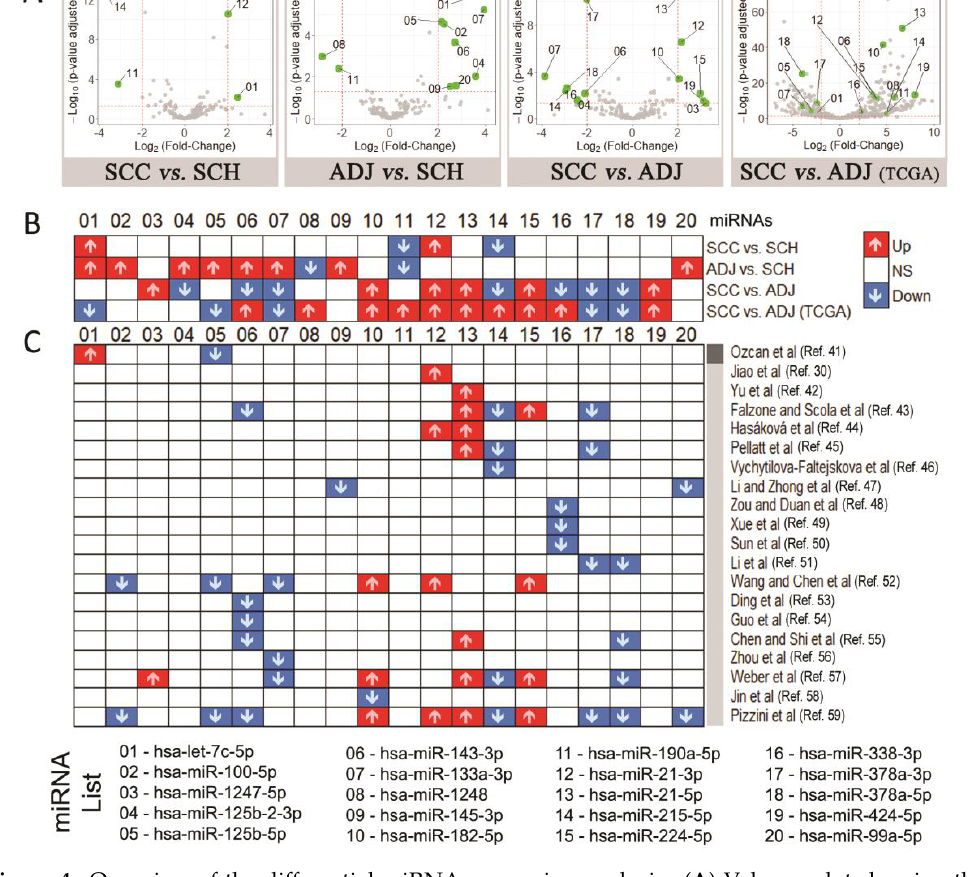
Figure 4. Overview of the di ff erential miRNA expression analysis. ( A ) Volcano plot showing the di ff erential expression analysis, ( B ) an overview of 20 di ff erential expressed miRNAs in this study, and ( C ) a comparison of these 20 miRNAs with results of previous studies with CRC patients. These studies were annotated as Dark-grey and Light-grey according to tissue considered as reference. Dark-grey = this study used a biopsy of a healthy subject as a reference against Colorectal Cancer (CRC). Light-grey = these studies used adjacent-tumor tissue as the reference against CRC. Note: Sigmoid Colon Cancer (SCC); Sigmoid Colon Healthy (SCH); Adjacent to Sigmoid Colon Cancer (ADJ). Up = Upregulated. Down = Downregulated. NS = Not-significant or